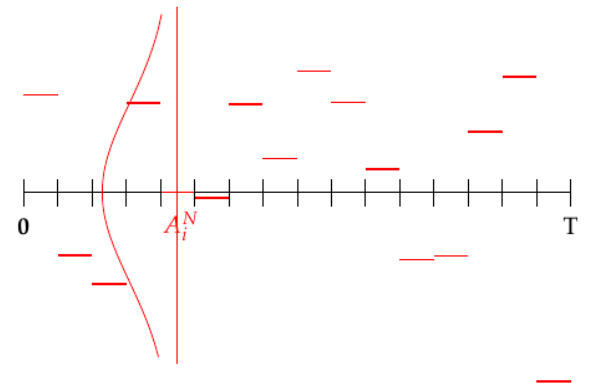
Figure 1. In red, plot of the approximation ξ N